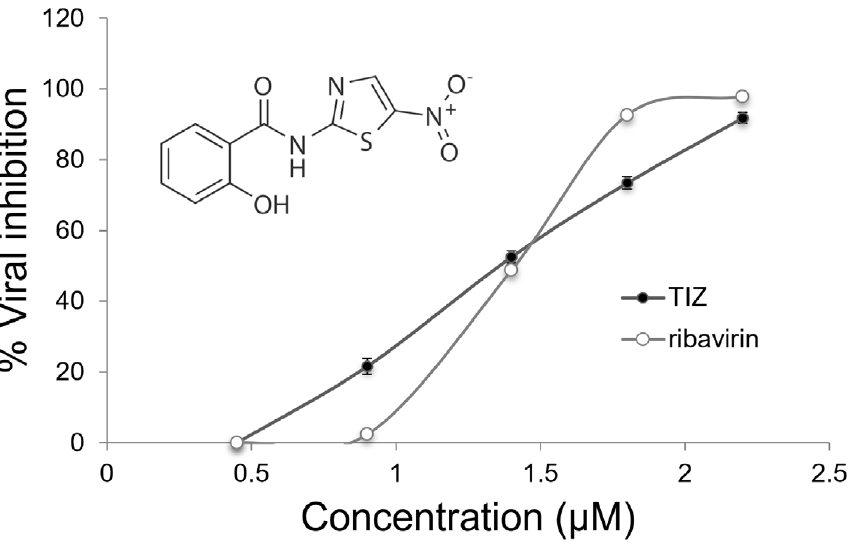
Figure 1. TIZ dose-response inhibition curve on DENV-2 replication in Vero cells. Different concen- trations of TIZ were added to Vero cells for 72 h, right after viral infection. Then, the viral yield was titrated by plaque assay and the values were converted to %VI. The experiment shows the mean of three determinations of viral inhibition in plaque assay, compared to non-treated cell controls ± SD. The SD bars are obscured by the dot. Chemical structure of TIZ in the insert. Table 1. Cytotoxicity and anti-DENV-2 activity of TIZ and ribavirin.